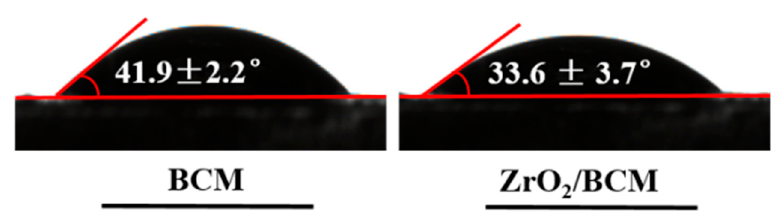
Figure 7. Contact angle images of BCM and ZrO 2 /BCM. Table 2. Membrane performance parameters of BCM and ZrO 2 /BCM. Table 2. Membrane performance parameters of BCM and ZrO